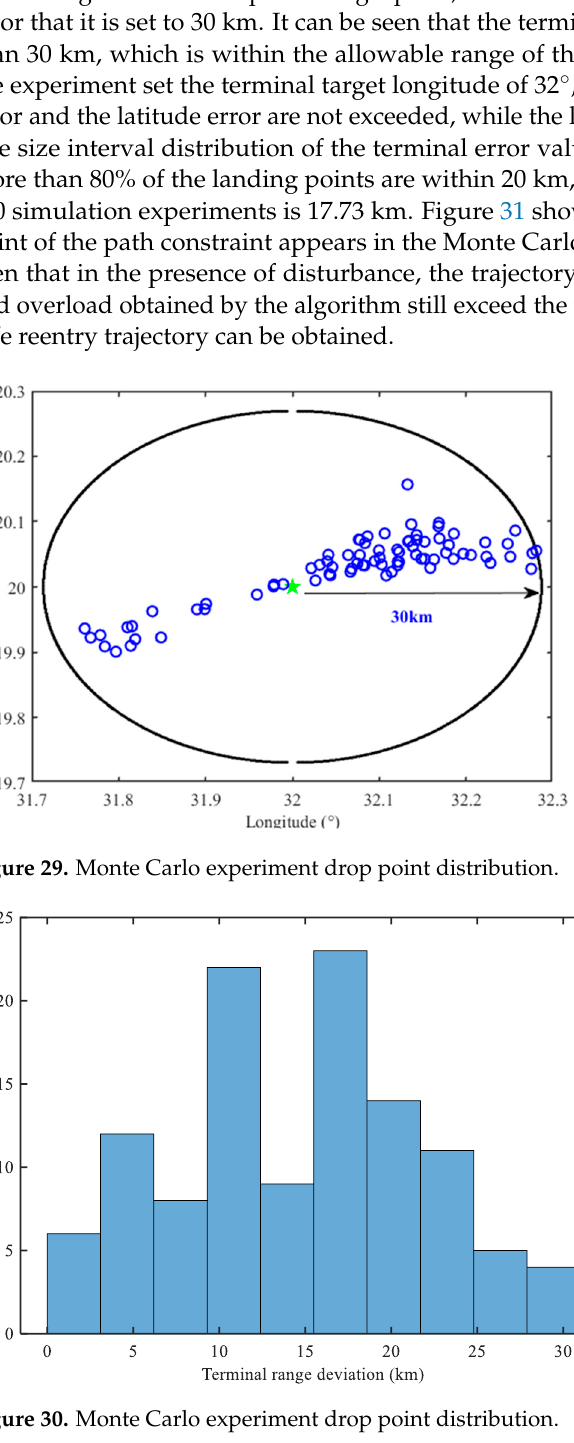
Figure 28. Latitude and longitude changes.